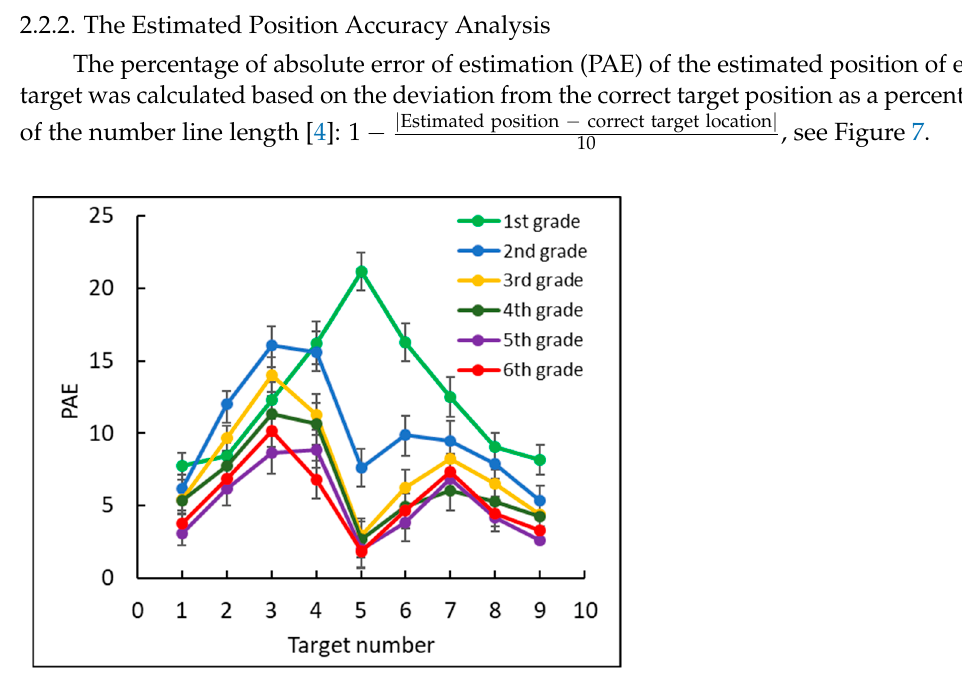
Figure 7. The percentage of absolute error (PAE) by target number for each grade.